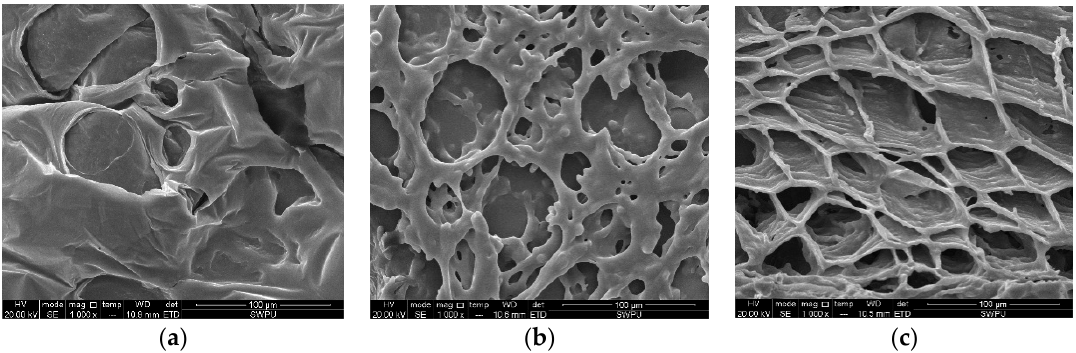
Figure 4. The Scanning electron microscopy (SEM) images of ( a ) VES-T solution without any counter-ion (served as a blank control); ( b ) VES-T solution with NaSal; ( c ) VES-T solution with KCl. The cross-linked networks could be observed in both ( b ) and ( c ) in comparison to ( a ).